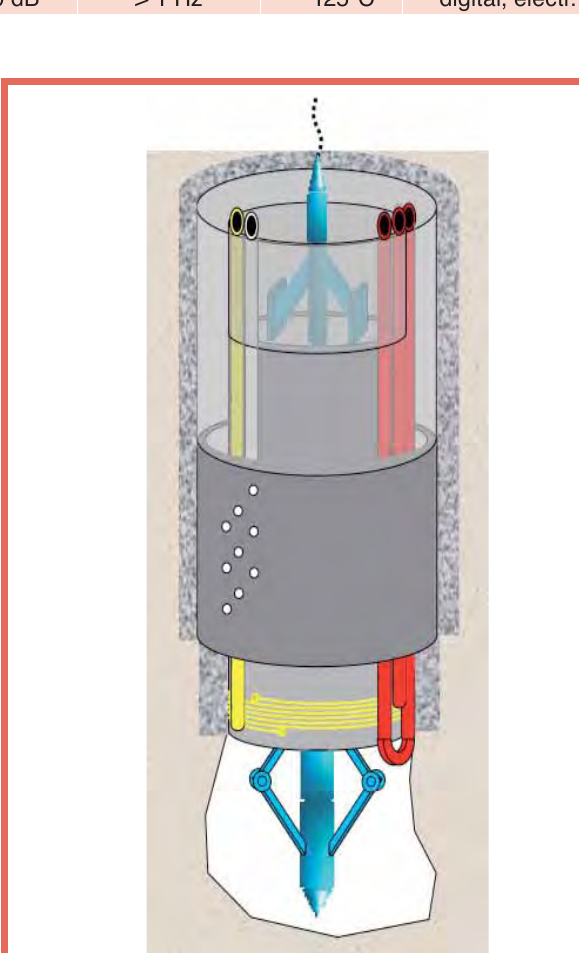
Figure 2. Sketch of showcase instrument array for a lower open-hole section. Two casings (partly drawn transparent) are cemented in place to achieve best possible coupling to the borehole wall. The inner casing is permanently instrumented on the outside with Type-1 fi ber-optic (red) and electric (yellow) cables as well as fl uid (white) pressure hoses to the surface. Inside is a cable- or pipe-deployed monitoring array (blue) for permanent high-resolution observations as per Type-2 (e.g. tilt- and strain-meters, pressure and temperature gauges, electro-kinetic tools, or seismometers). The measurement cable or pipe is retrievable for instrument check, repairs, and replacements; it can be repositioned at a different depth in the borehole. Perforations on the outer casing are for chemical fl uid monitoring and for collecting samples.